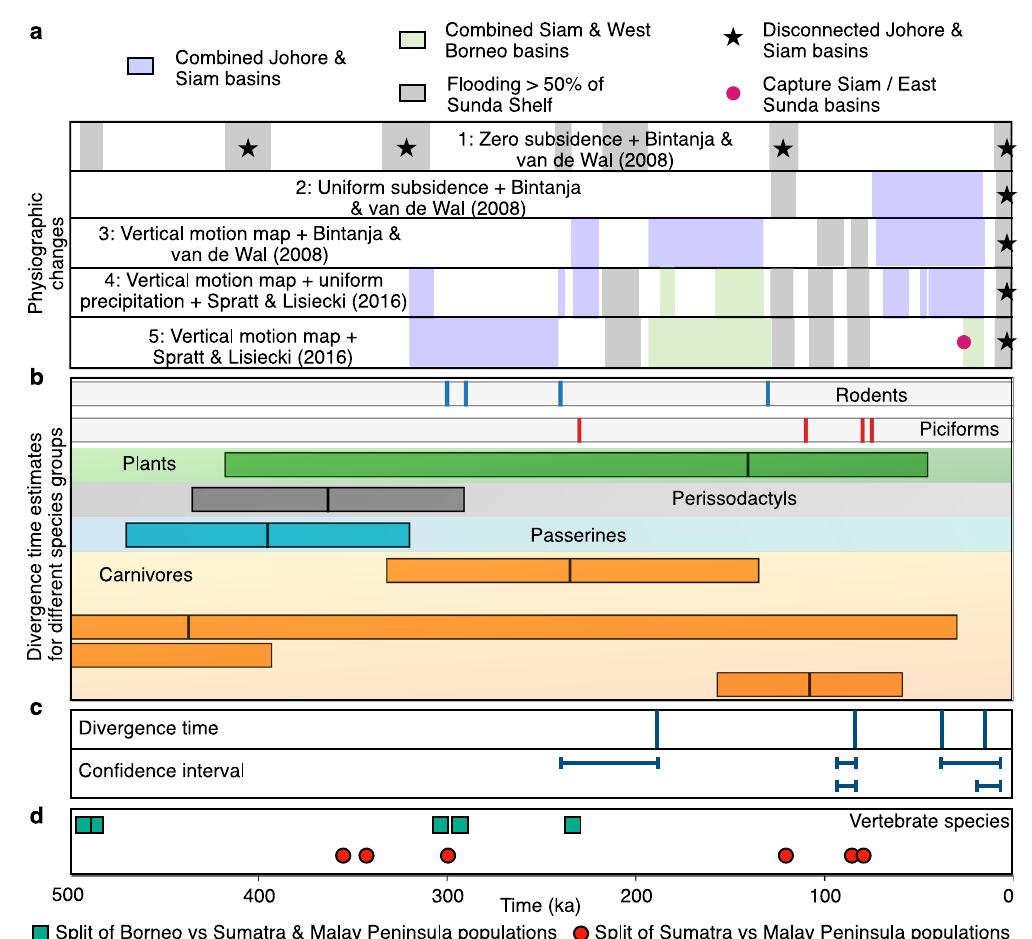
Fig. 2 Physiographic changes and regional species dispersal. a Physiographic changes for each landscape evolution simulation from scenarios 1 – 5 (basin reorganisations, drainage captures, fl ooding and disconnections between main landmasses). b Estimated divergence through time (coloured rectangle: left and right sides are the min and max divergence time, and the middle line is the mean) for different terrestrial organisms (carnivores 62 – 65 , passerines 3,66,67 , barbets 68 , perissodactyls 69 and plants 70 ). Estimated divergence time for piciforms 6 and rodents 16,71 without con fi dence intervals are in red and blue, respectively. c Estimated time of divergence and con fi dence interval for songbird species 21 . d Age estimates of population split within vertebrate species 6 between Borneo, Sumatra and the Malay Peninsula. Main divergence times presented in b are extracted from Table 1 in 18